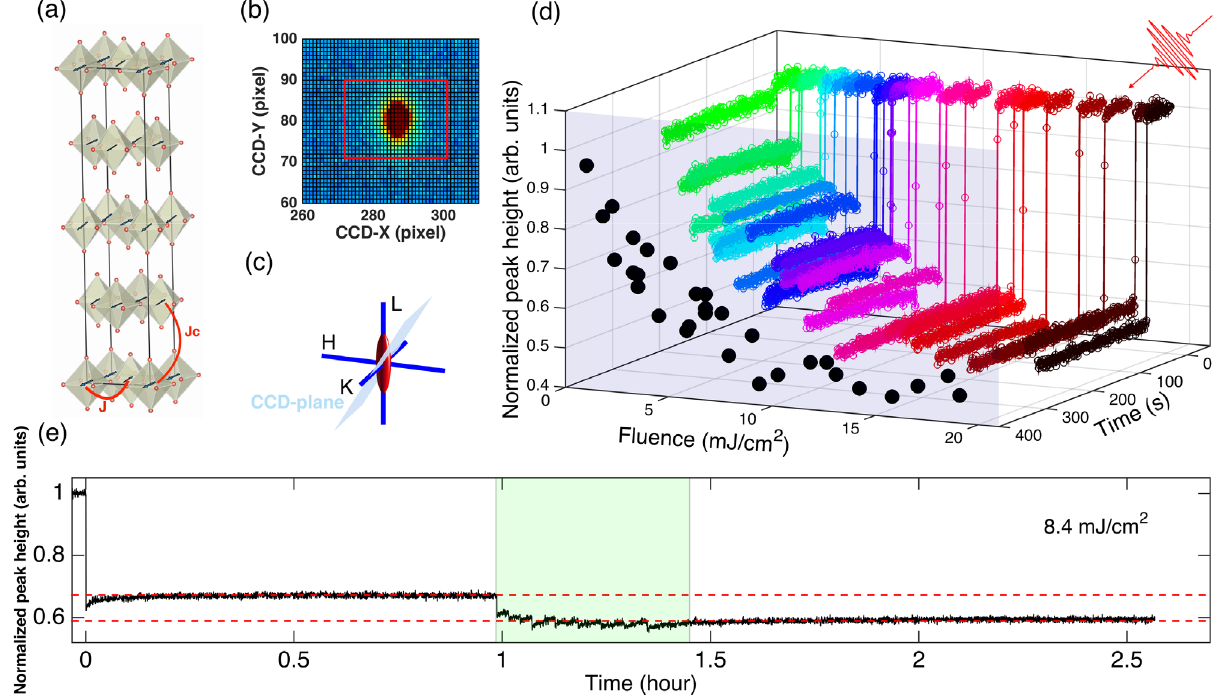
FIG. 1. Single-laser-pulse-induced suppression of the (1 0 16) magnetic reflection. (a) The crystal and magnetic structure of Sr 2 IrO 4 . J and J c denote the in-plane and interplane exchange couplings, respectively. (b) CCD image of the magnetic peak. (c) Cartoon demonstration of the projection of the CCD plane in the reciprocal space. (d) Response of the magnetic Bragg-peak height to a single laser pulse (arrives at t ¼ 0 ) as a function of the laser fluence. The black dots are the average of the last 100 s of each curve. (e) Multiple- shot evolution of the magnetic-peak height with moderate laser fluence. Multiple shots arrive in the shaded region, and each creates a small intensity drop until the decrease is fully compensated by an initial